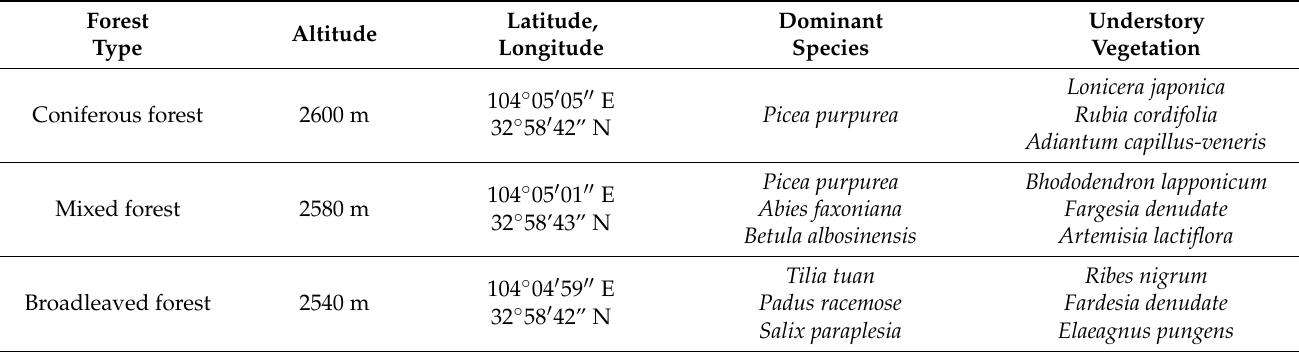
Figure 1. Schematic diagram showing the location of our study in the subalpine forest. Table 1. Dominant species and understory vegetation of three forest types.